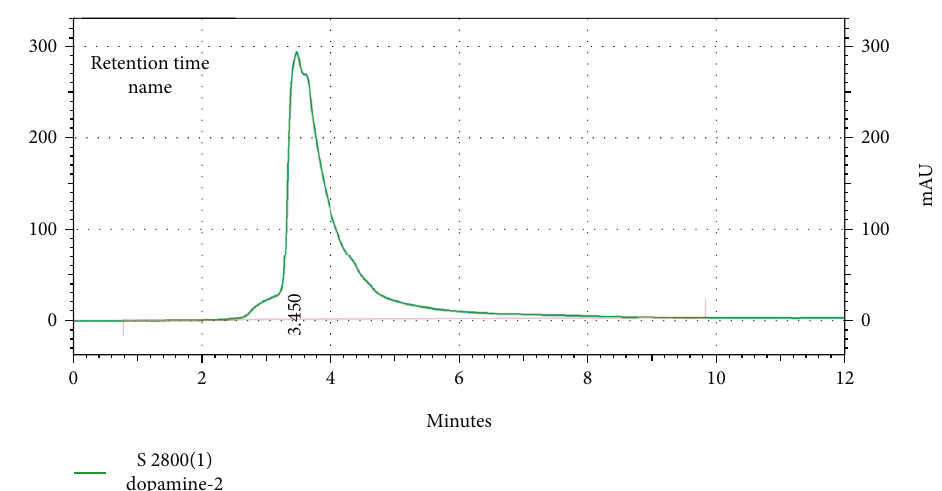
Figure 2: Retention time of the standard sample of dopamine (concentration: